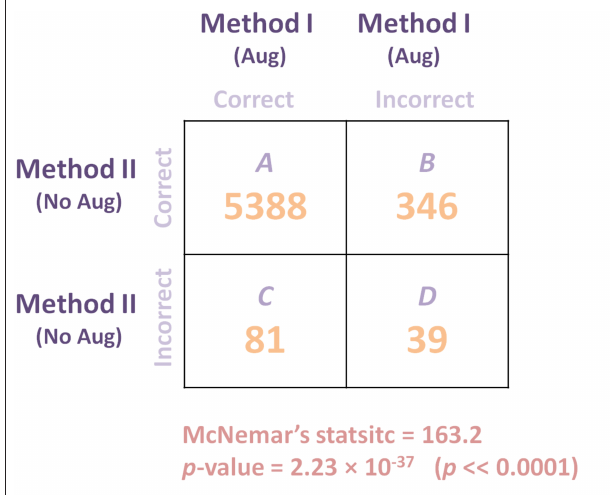
FIGURE 6 | Comparing the performance of two models (with and without augmentation) on Dataset 4 (Testing) of a recently published algorithm ( 19) for detecting COVID-19 after training the algorithm on Dataset 1 (Training and Validation). McNemar’s Test was used to compare the predictive accuracy of two models: Method I (augmentation) and Method II (no augmentation). B is the number of X-ray images that were detected correctly by Method II and incorrectly detected by Method I, while C is the number of X-ray images that were detected correctly by Method I and incorrectly by Method II. Results show that the deep learning model without augmentation (Method II) significantly outperformed the same model with